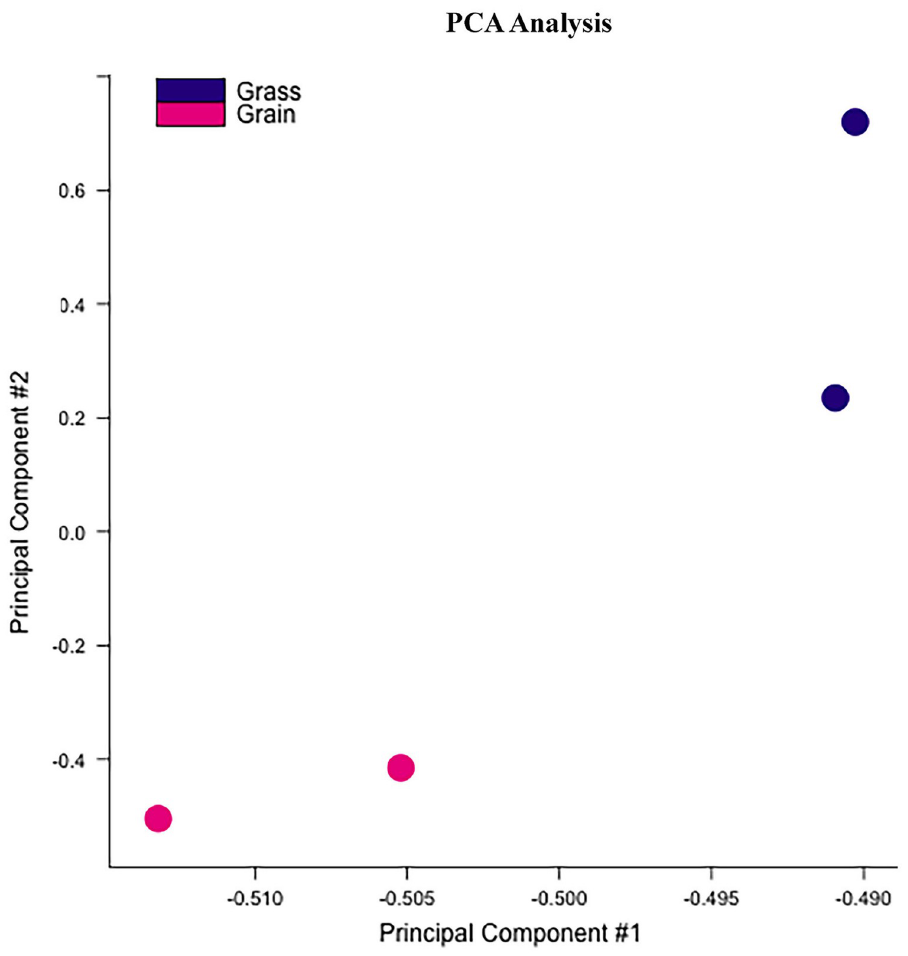
Fig 2. PCA analysis of the experimental individuals based on the identified DMRs. PCA: principle component analysis.